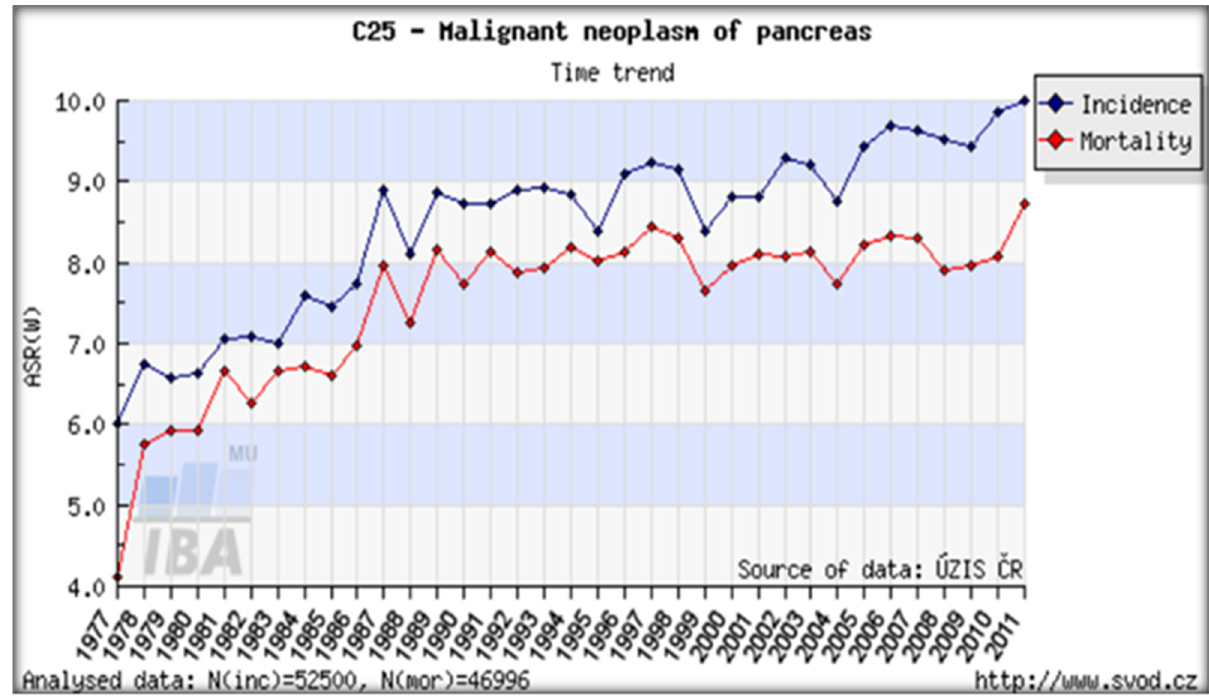
Figure 8. Trends of PC incidence and mortality (1977–2011) in a country of Central-Eastern Europe particularly hit by the Chernobyl radioactive cloud. PC incidence and mortality rates in the Czech Republic (both sexes). Data source: CNCR [47].